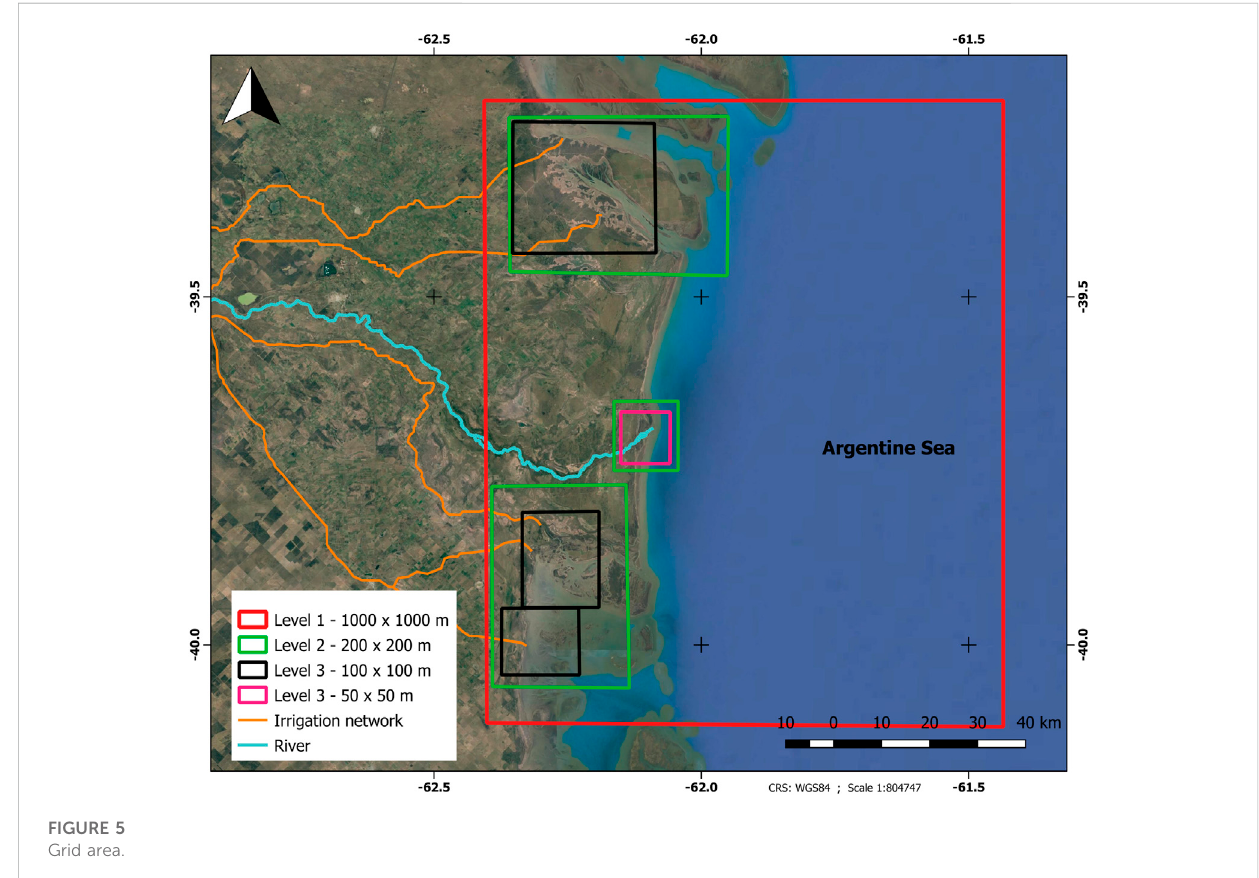
FIGURE 5 Grid area.